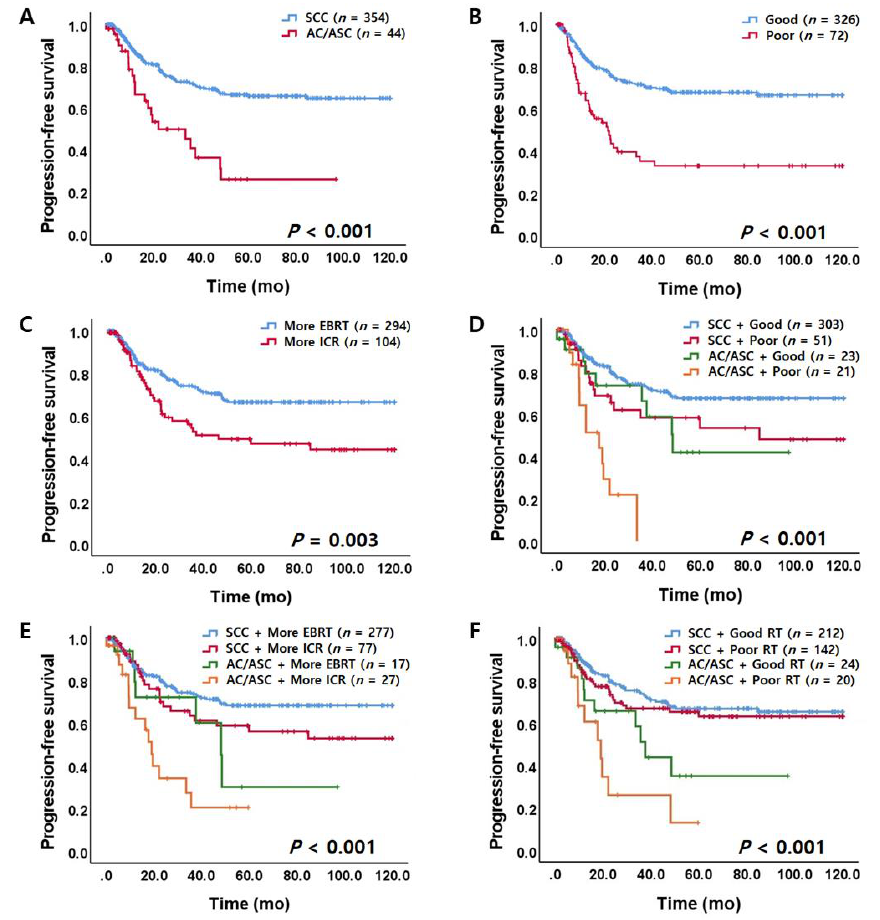
Figure 2. Progression-free survival (PFS) according to histologic subtype and responsiveness to RT. ( A ) PFS according to histologic subtype. ( B ) PFS according to post-external beam radiotherapy (EBRT) regression . ( C ) PFS according to EBRT proportion . ( D ) PFS according to histologic subtype and